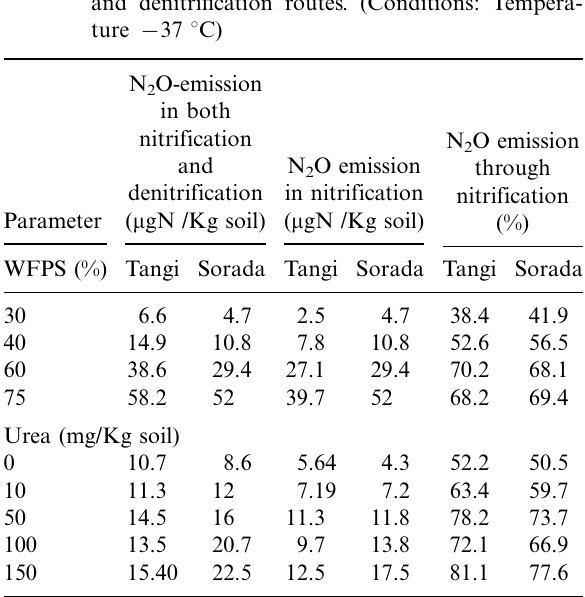
Table 2. Nitrous oxide (N 2 O) emission through nitrification and denitrification routes. (Conditions: Tempera- ture (cid:3) 37 8